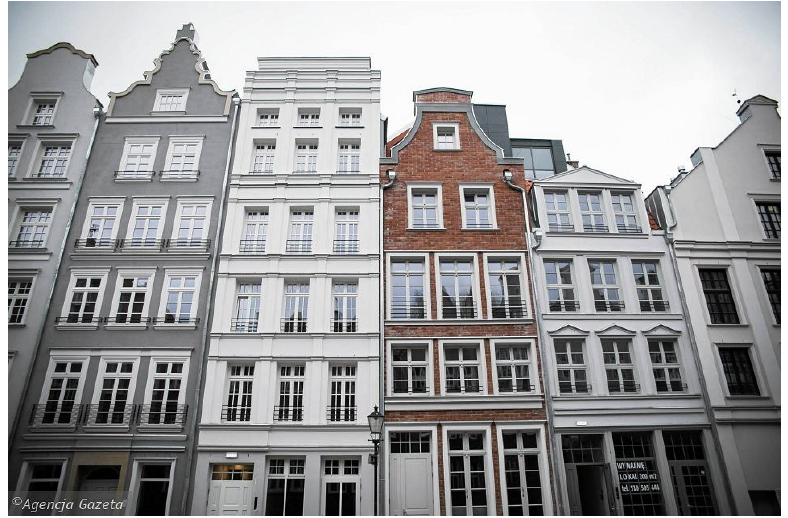
Figure 11. Tenement houses in Ś w. The Church of the Holy Spirit in Gda ń sk; designed by P. W. Kowalski [53].